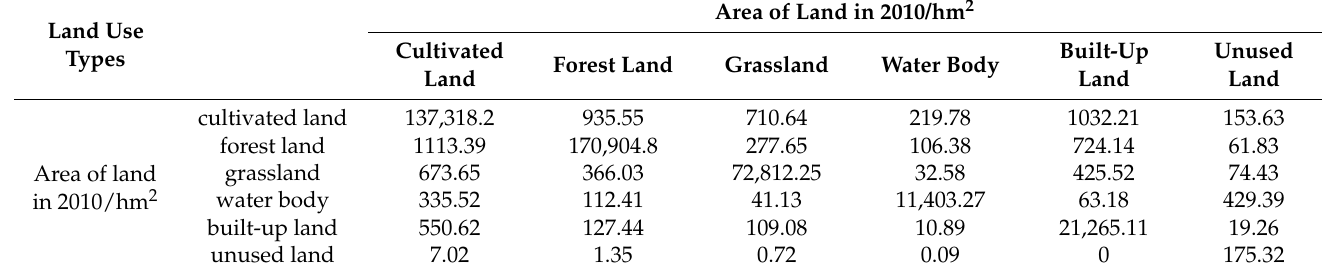
Table 3. Land use transfer matrix from 2010 to 2018 (hm 2 ).